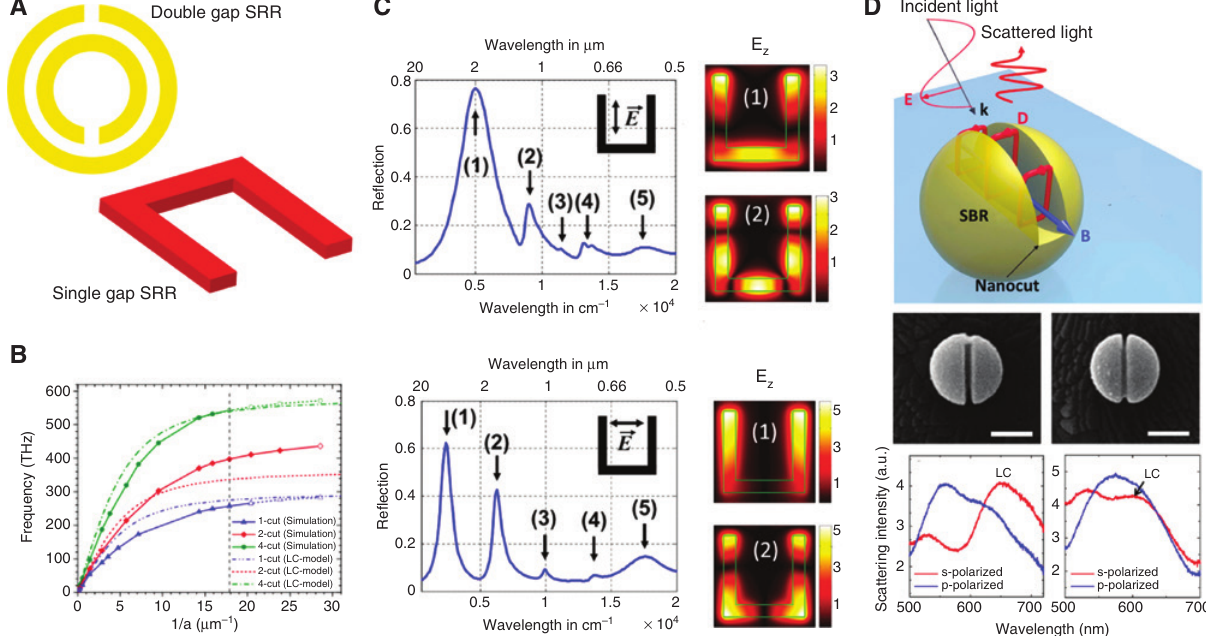
Figure 1: Planar and 3D split ring resonator (SRR). (A) Top, the SRR originally proposed by Pendry [37]. Bottom, low footprint version of SRR, suitable for scaling the device to target the optical range [38]. (B) The spectral shift of the magnetic resonance mode with respect to the SRR size. Despite the increase in the number of gaps in order to reduce the net capacitance of the system, the linear scaling law holds only in the low energy limit. Reprinted with permission from Zhou J, Koschny T, Kafesaki M, Economou EN, Pendry JB, Soukoulis CM, Phys Rev Lett, 95, 223902, 2005. Copyright 2005 by the American Physical Society (Ref. [39]). (C) Top, spectral distribution for the first five modes excited under the E polarization and near-field maps of the ⊥ absolute value of the local E field normal component for the first two modes. Bottom, spectral distribution for the first five modes excited under the E polarization and near-field maps of the absolute value of the local E field normal component for the first two modes. Adapted // with permission from Ref. [38], 2006 Optical Society of America. (D) Top panel, schematic of the Split Ball Resonator, the 3D analogue of the planar SRR. The cut in a gold nanoparticle was performed through Focused Helium Beam milling, resulting in a low defect architecture (middle panel). Bottom panel, scattering spectra of the two particles in the middle panel for incident s- (red curves) and p-polarized (blue curves) light. The accuracy of fabrication enables the device operation at optical frequencies. Panel (D) has been reprinted by permission from Springer Nature, Nat Commun 2014;5:3104 Split-ball resonator as a three-dimensional analogue of planar split-rings. Kuznetsov